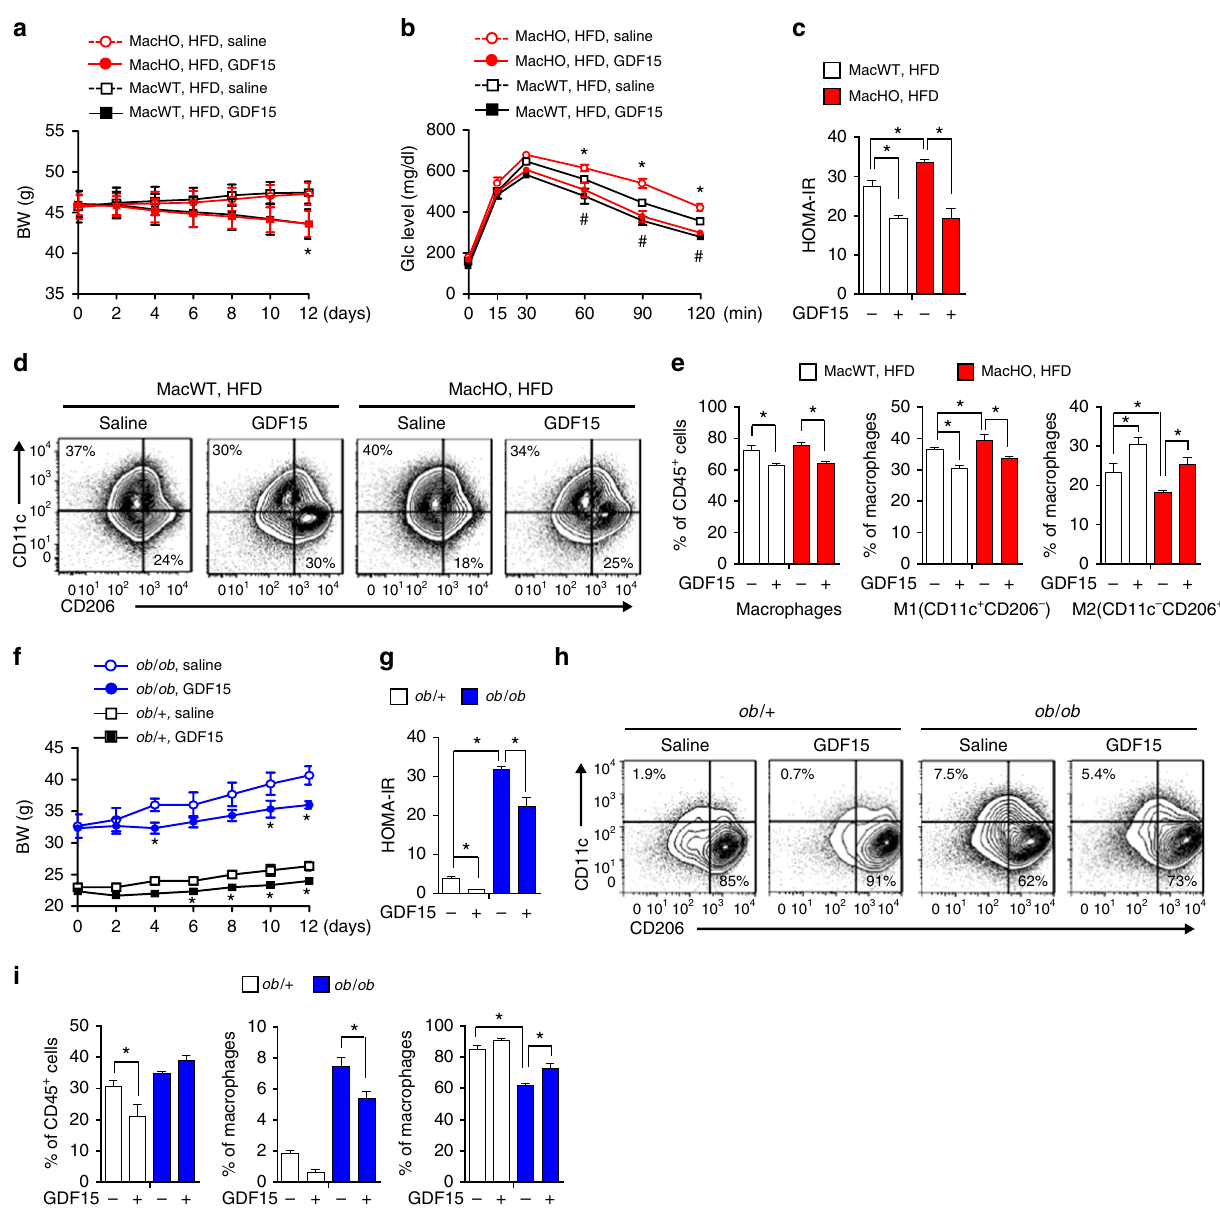
Fig. 8 GDF15 reverses insulin resistance caused by reduced oxidative function. a Body weight changes in MacWT or MacHO mice fed a HFD for 12 weeks and intraperitoneally injected with rGDF15 (300 μ g/kg) every other day for 2 weeks ( n = 5 per group). b IPGTT performed after rGDF15 treatment. c HOMA-IR of HFD-fed MacWT and MacHO mice after treatment with rGDF15. d , e FACS analysis of macrophages (CD45 + /F4/80 + /CD11b + ) and M1 (CD11c + /CD206 - ) and M2 (CD11c - /CD206 + ) macrophages in fi ltrated into eWAT. f Body weight changes in ob/ + and ob/ob mice treated with rGDF15 (300 μ g/kg) for 2 weeks ( n = 5 per group). g HOMA-IR of ob/ + and ob/ob mice after GDF15 treatment. h , i FACS analysis of macrophages (CD45 + /F4/ 80 + /CD11b + ) and M1 (CD11c + /CD206 - ) and M2 (CD11c - /CD206 + ) macrophages in fi ltrated into eWAT of ob/ + and ob/ob mice. Data represent means ± SEM and are representative of three independent experiments. * p < 0.05 (two-tailed Student ’ s t